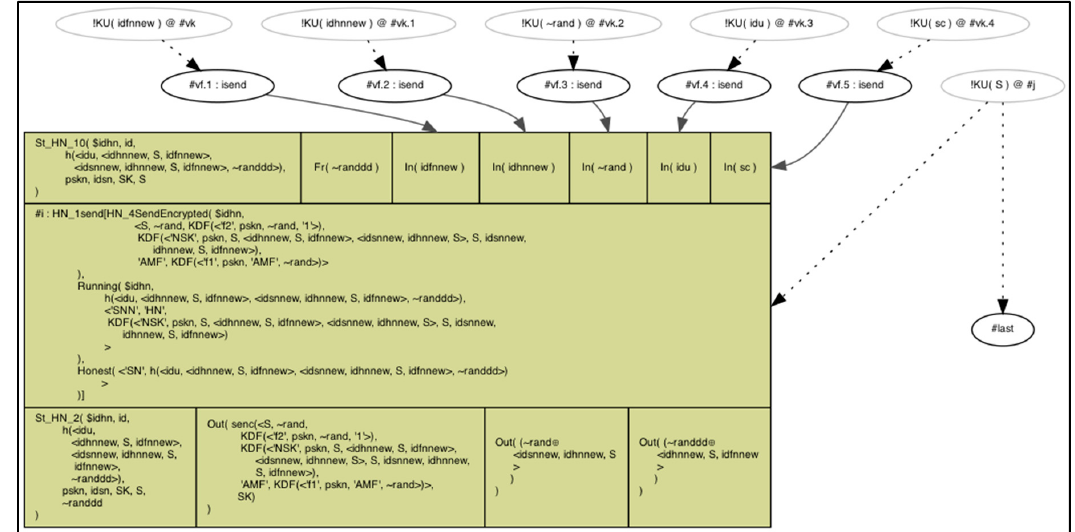
Figure 13. Replay attack resistance in HN .